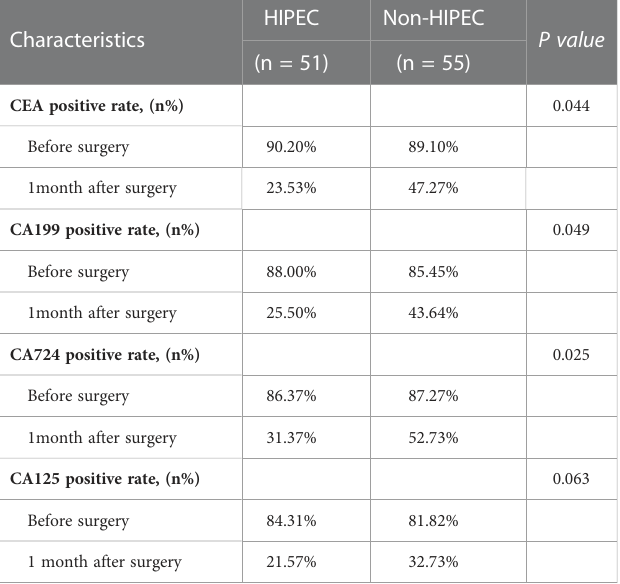
TABLE 3 Comparison of the tumor markers positive rates between the two groups before surgery and 1 month after surgery.